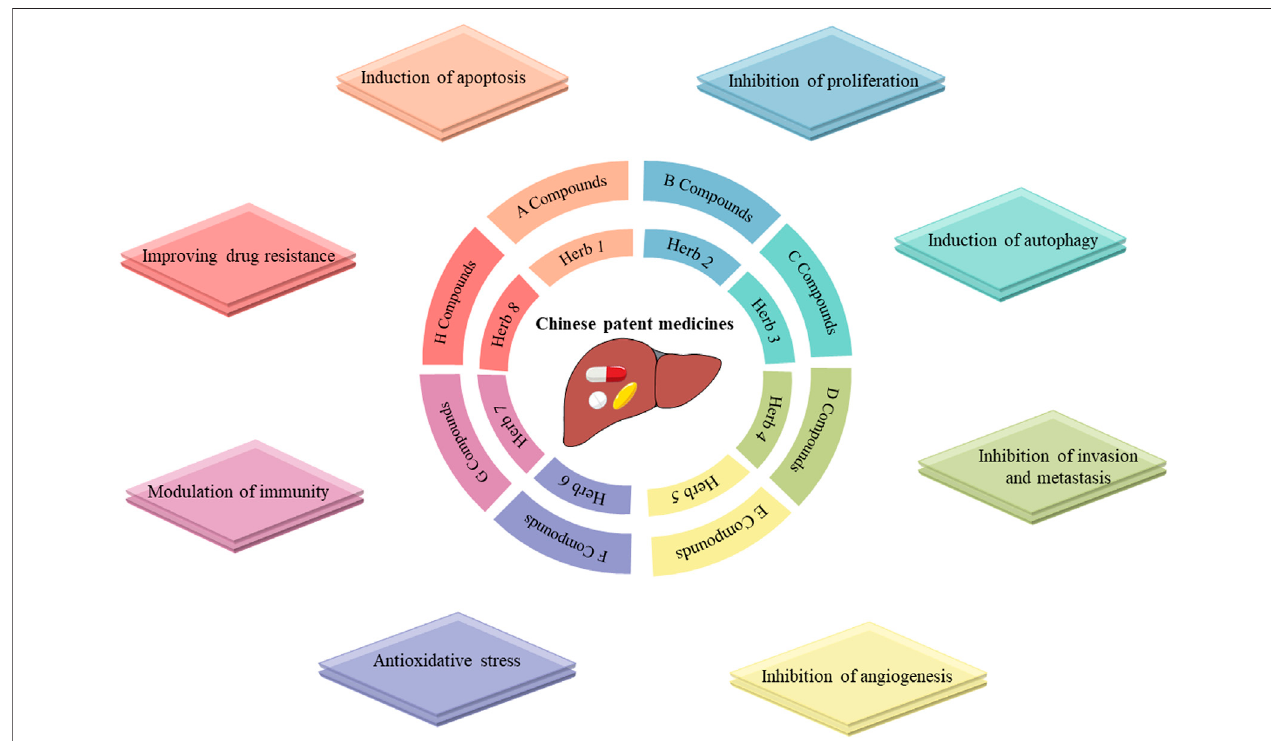
FIGURE 1 | Mechanisms of Chinese patent drugs against primary liver cancer. Notes: Chinese patent medicines often comprise of one or more herbs, each containing various compounds that exert different antitumor activities.